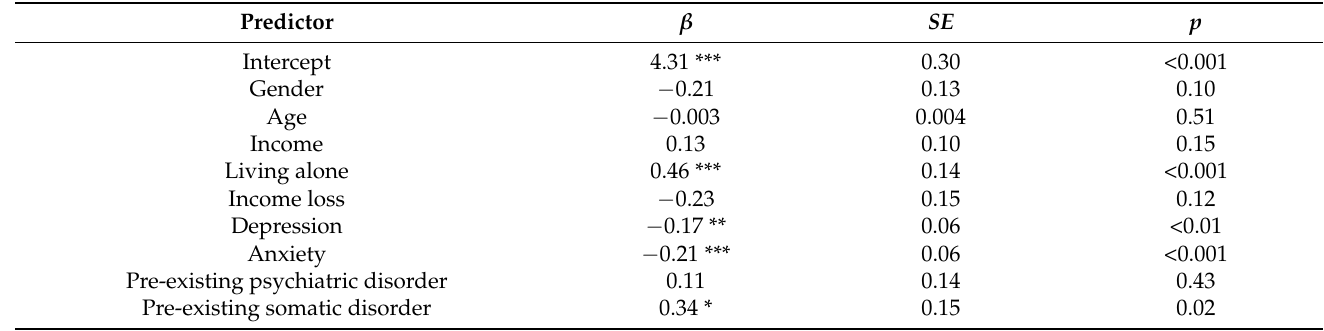
Table 3. Associations of sociodemographic characteristics and mental health with life satisfaction in the high-risk group of participants with lower life